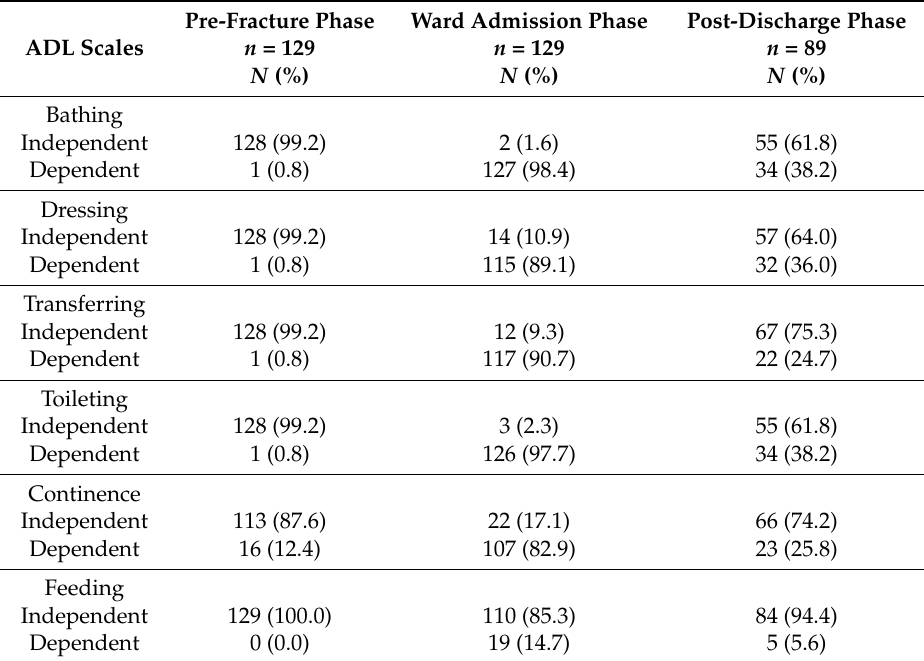
Table 3. Frequency and percentage of subjects for all activities of daily living in all three